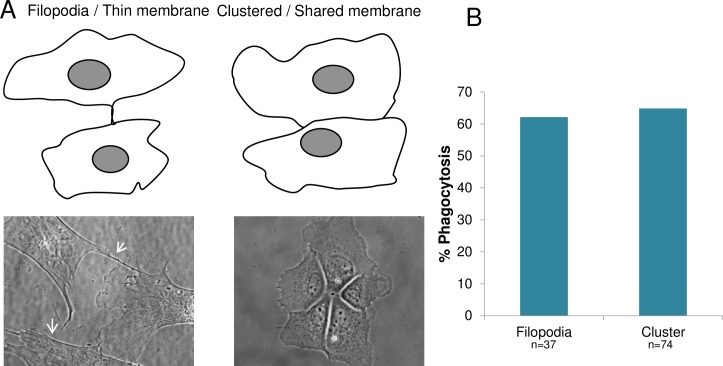
Amount of shared membrane does not affect the phagocytic response of astrocytes.A. Cells were categorized by the amount of membrane connection shared between two astrocytes. Two different connections between cells were observed: those with thin filopodial connections “Filopodia/ thin membrane”, and clusters of cells with large amount of shared membrane, “Clustered/ shared membrane”. Phase contrast images (contrast enhanced) show representative cells below the schematic diagram of the two categories of observed membrane connections. White arrows show thin filopodial connections, while significantly more shared membrane between cells is visible in the cell cluster on the right. B. No significant difference in phagocytosis was observed between cells sharing thin filopodial connections versus cells in clusters with significant shared membrane: 62% (23/37) and 65% (48/74), respectively.